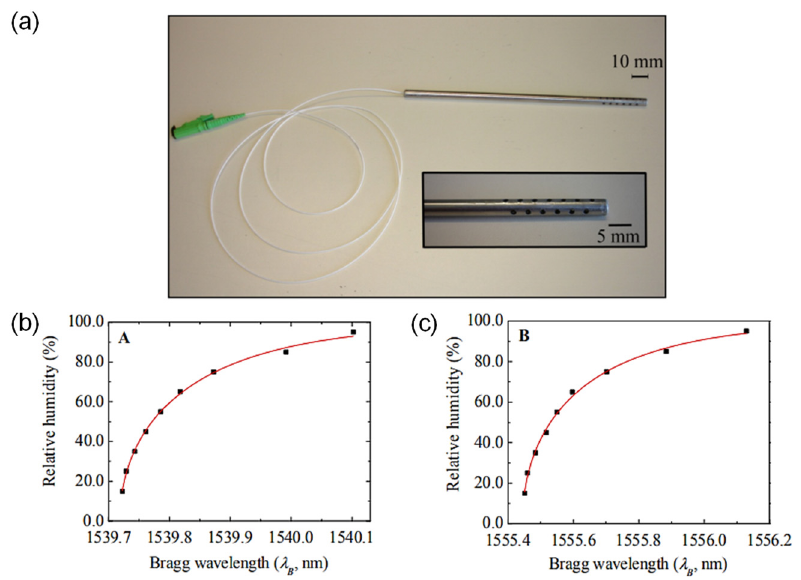
Figure 18. Point sensor. ( a ) Photograph of sensor head. Bragg wavelength dependence on RH for ( b ) FBG A, and ( c ) FBG B. Adapted with permission from ref. [78]. Copyright 2012 MDPI Tao Li et al. [80] developed a humidity sensor using a combination of tapered MMF, PVA coating, and FBG. The LOD is 1%RH, while the response time is 2 s. The sensitivity is 1.994 µW/%RH between 30%RH and 95%RH. The dynamic range is 30%RH–95%RH.